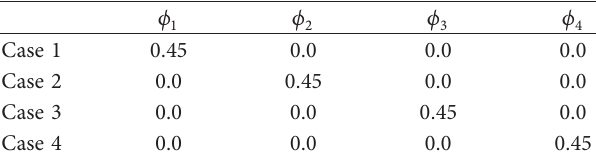
Table 3: Fuel injection conditions for Cases 1–4.